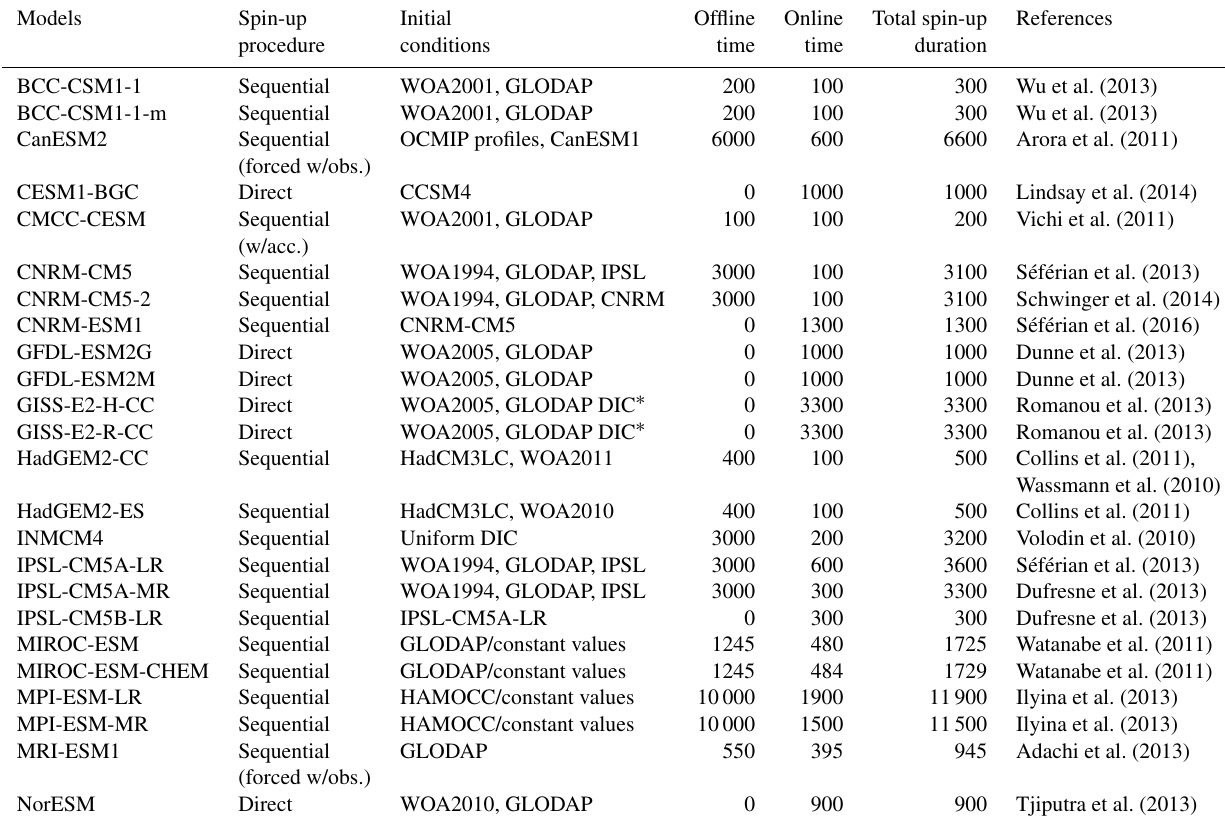
Table 1. Summary of spin-up strategy, sources of initial conditions, offline/online durations and references used to equilibrate ocean biogeo- chemistry in CMIP5 ESMs. The so-called direct and sequential strategies inform whether the spin-up of the ocean biogeochemical model is run directly in online/coupled mode or first in offline (ocean biogeochemistry only) and then in online/coupled mode. DIC ∗ refers to the observation-derived estimates of preindustrial dissolved inorganic carbon concentration using the (cid:49) C ∗ method. w/acc. and forced w/obs. indicate the strategy using “acceleration” and observed atmospheric forcings during the spin-up,